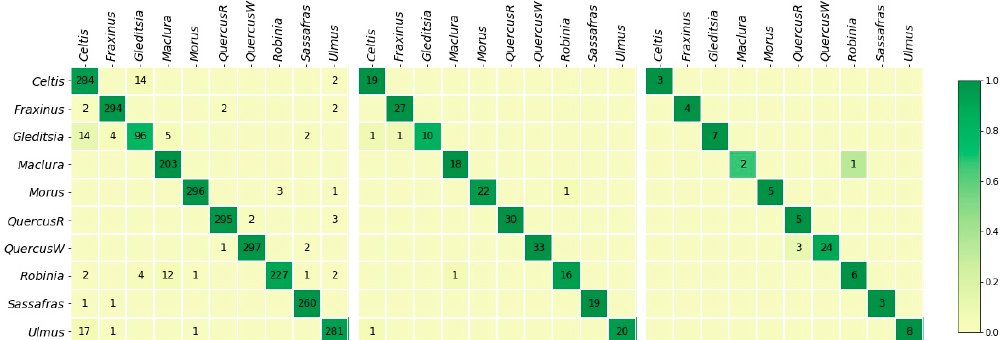
Figure 5. Confusion matrices for models trained on XT-train. ( Left ): Image-level confusion matrix for XT5 (accuracy: 96.1%). ( Middle ): Specimen-level confusion matrix for XT5 (the best of 10 random selections of 5 images per specimen, accuracy: 97.1%). ( Right ): Specimen-level confusion matrix for field model XTF predicting on XT-test (accuracy: 94.4%). Cross-validation confusion matrices were obtained by choosing up to five images per specimen and aggregating them over the five folds (also see supplementary materials).